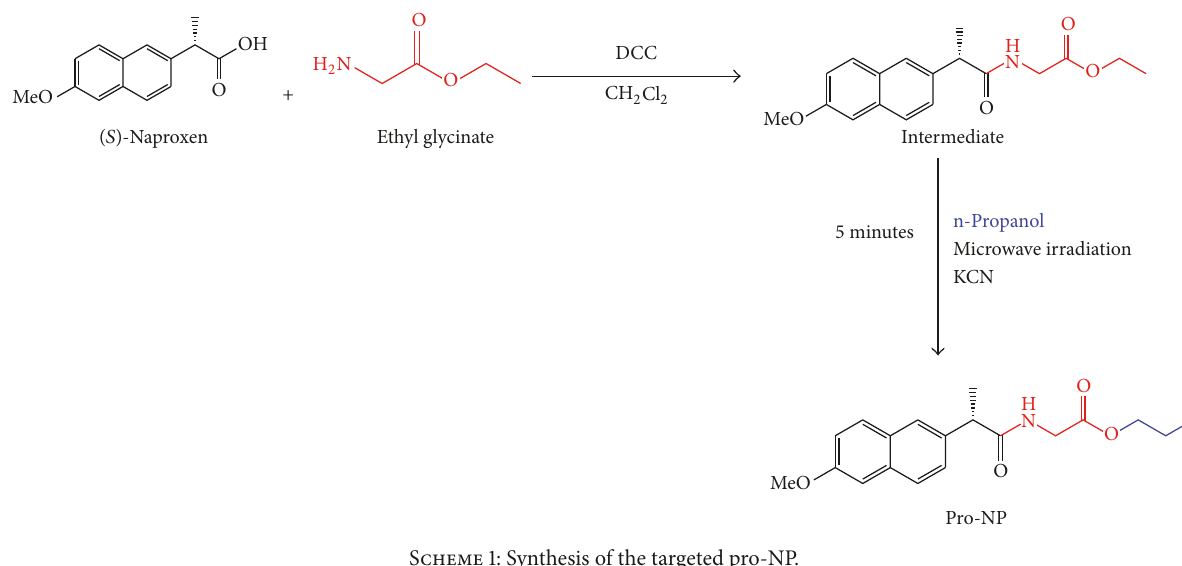
Scheme 1: Synthesis of the targeted